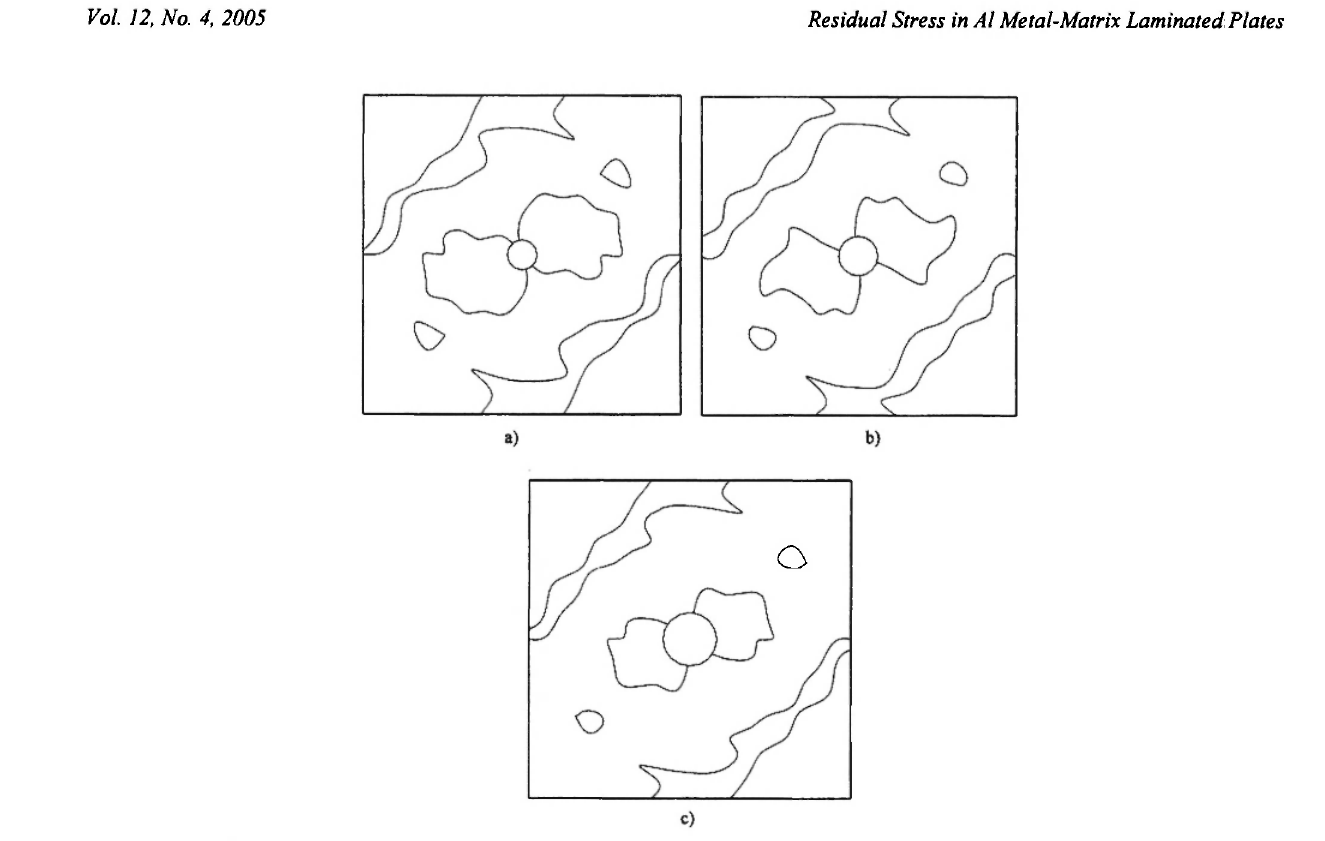
Fig. 3: The plastic region of the angle-ply plates, [30°/-30°] s : a) W/D=10, b) W/D=8, c)W/D=6.